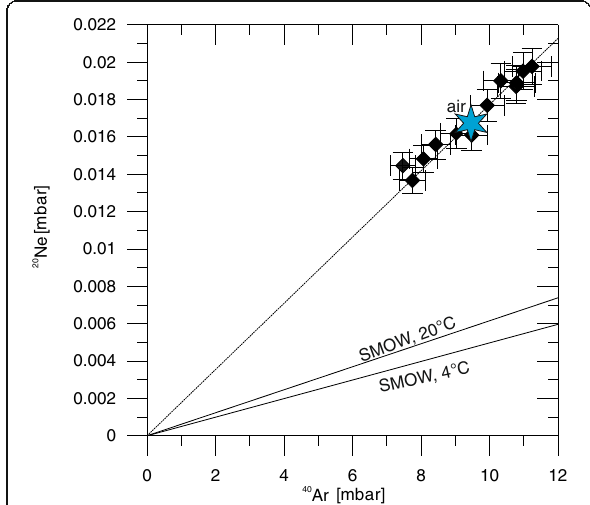
Fig. 2 20 Ne vs. 40 Ar diagram showing lines for variable contributions of air (dashed line) and for air-saturated standard mean ocean water (SMOW) at 4 °C and 20 °C. All data points fall on the mixing line with